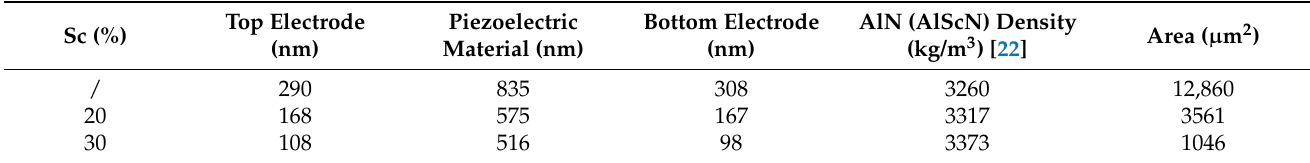
Table 1. The thickness of each layer, the concentration of Sc, the density of piezoelectric thin film and the area of resonators.